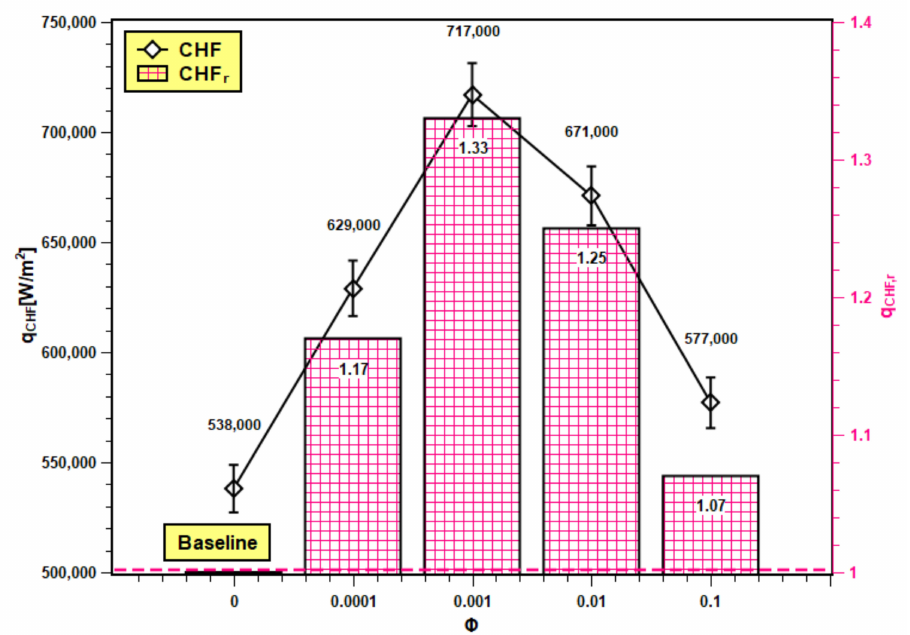
Figure 13. CHF and its enhancement in SiO 2